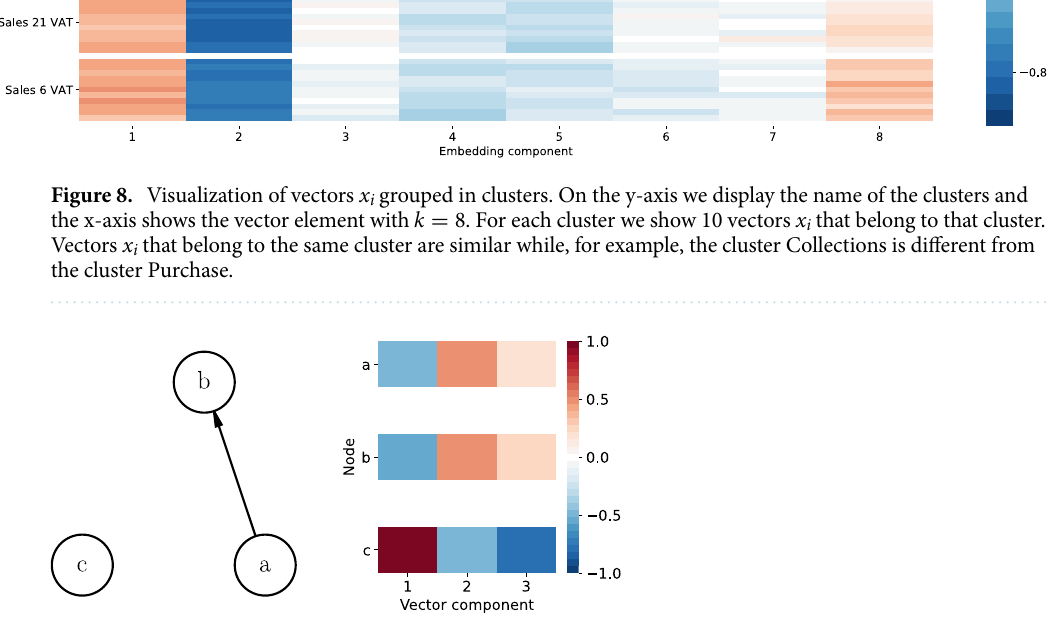
Figure 9. On the left an example network G. Node a and b are connected, therefore we expect that the vectors x a and x b of nodes a and b have values closer to each other compared to node c . On the right the visual representation of a k = 3 dimensional vector for each node. We observe that the colors of node c are different from those of nodes a and b